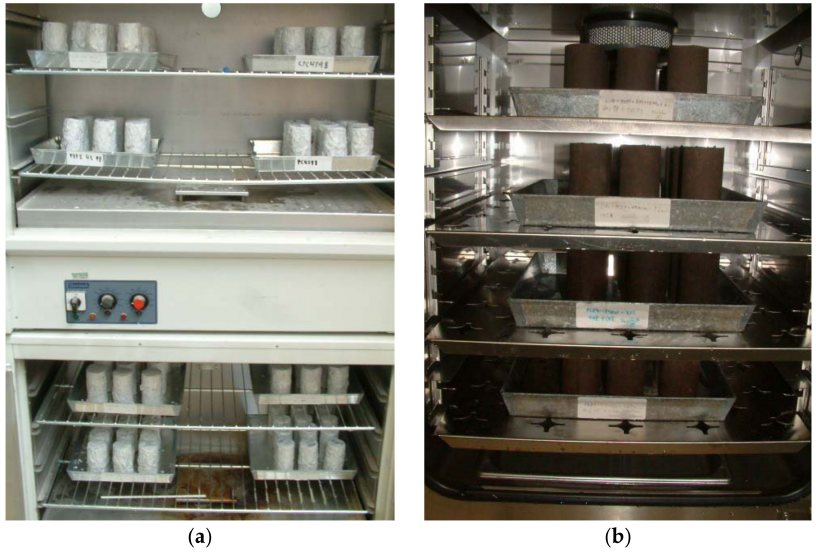
Figure 3. ( a ) Oven and ( b ) incubator used for the sample curing.